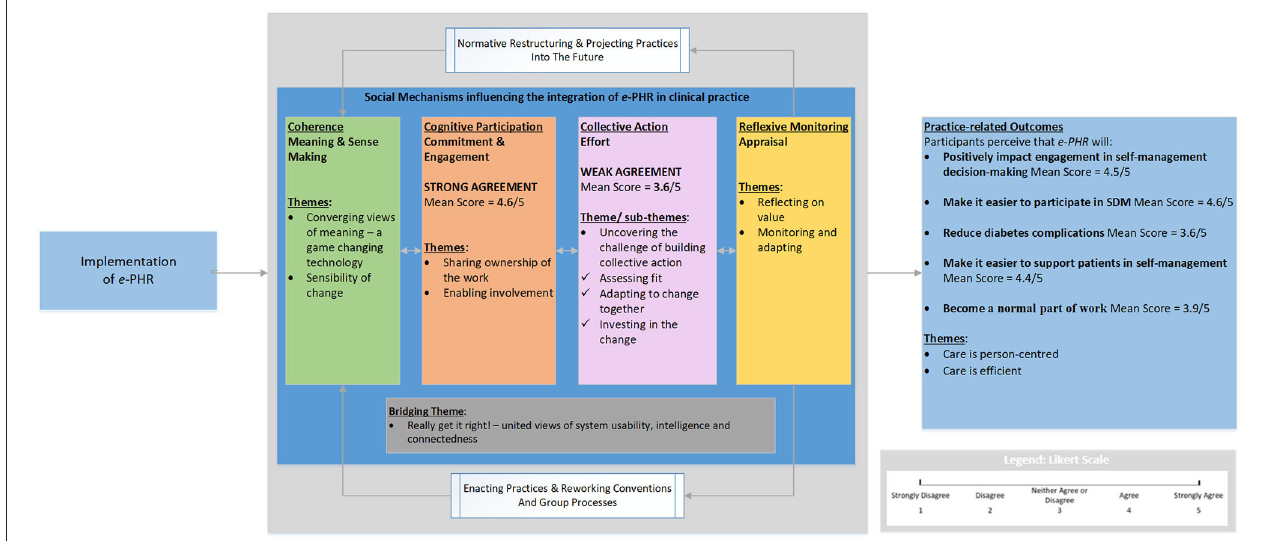
FIGURE 3 | Overall interpretation for the normalization of